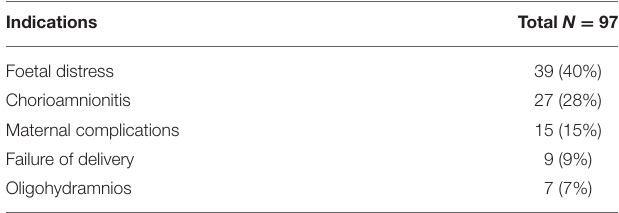
TABLE 5 | Indications for emergency caesarean section in women who attended to a pre-natal education course.